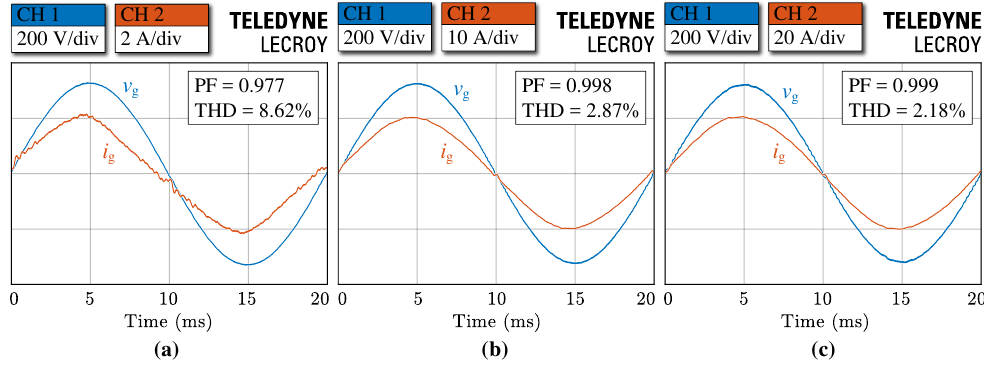
Figure 15. Experimental grid-side voltage ( v g ) and current ( i g ) waveforms for ( a ) 10% load ( P = 330W), ( b ) 50% load ( P = 1650W) and ( c ) 100% load ( P = 3300W). The scale of i g is changed according to P